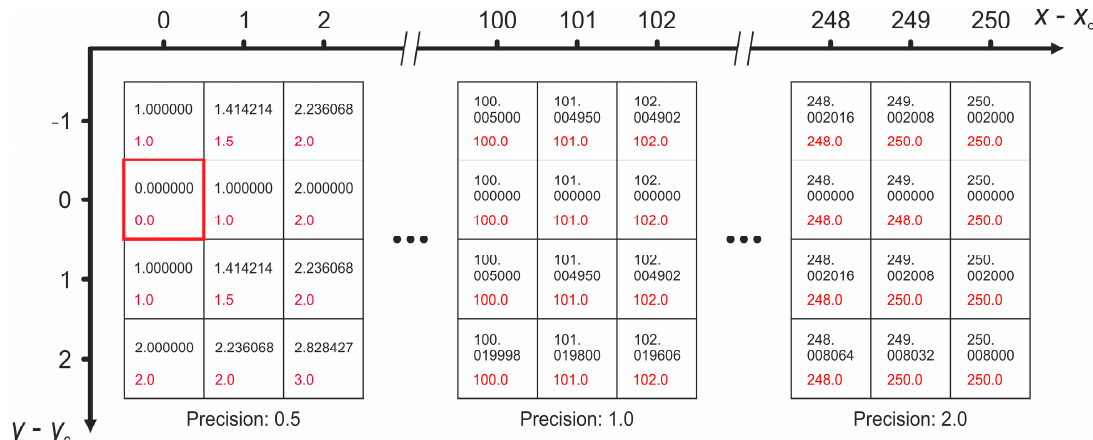
Figure 10. Rounding process for the values of the radial coordinate r px . Black numbers: exact values of r px and red numbers: rounded values of r px .